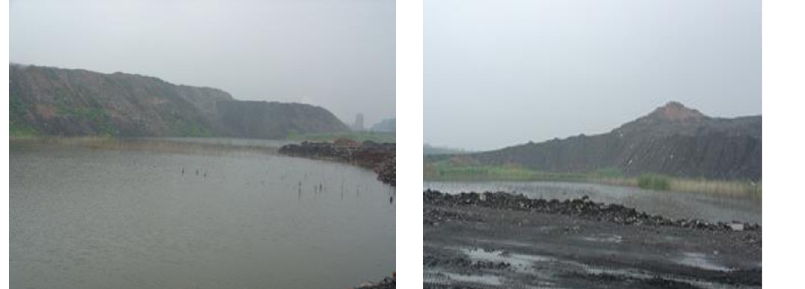
Fig 1. Test site before the DC test.